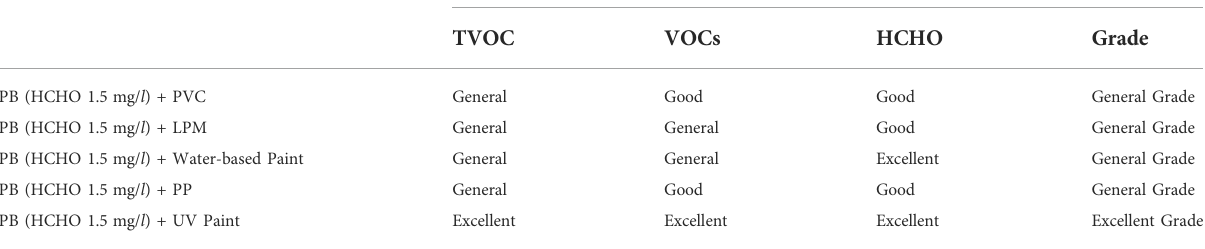
TABLE 5 BIFMA certi fi cation grade for each test piece. Test